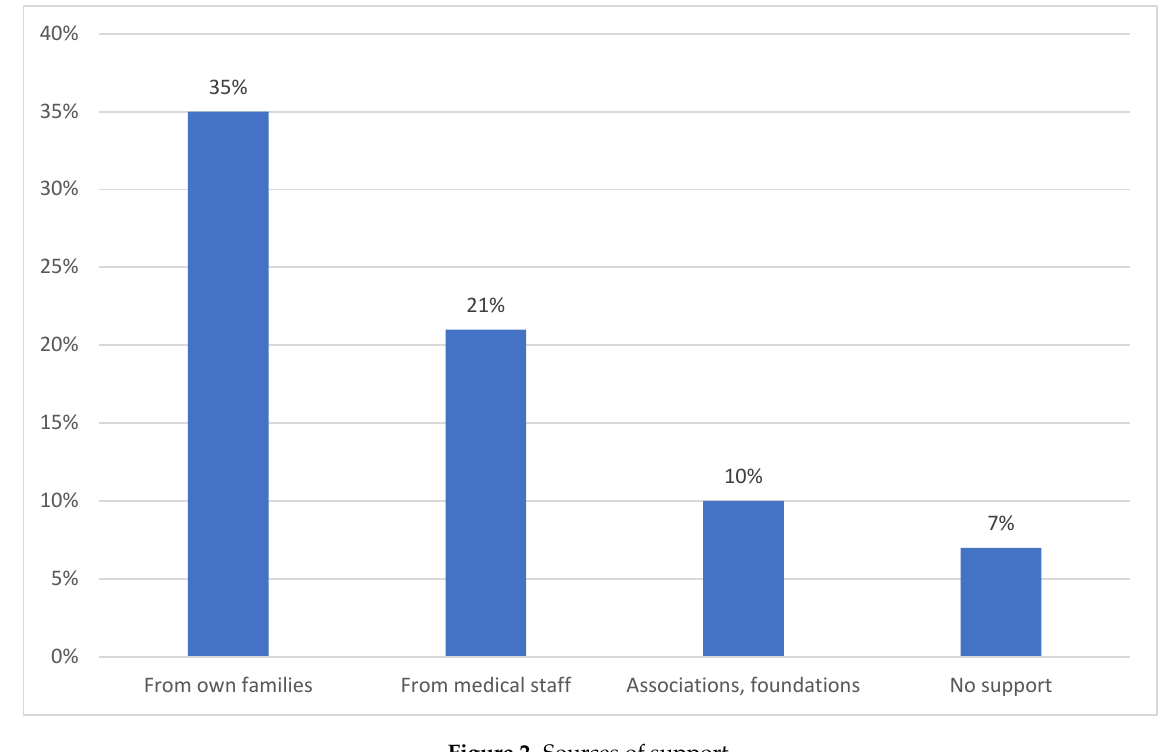
Figure 2. Sources of support.